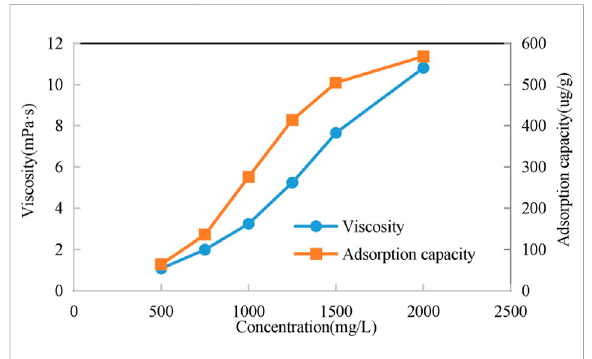
FIGURE 4 The relationship between chemical agent concentration and viscosity and adsorption capacity.